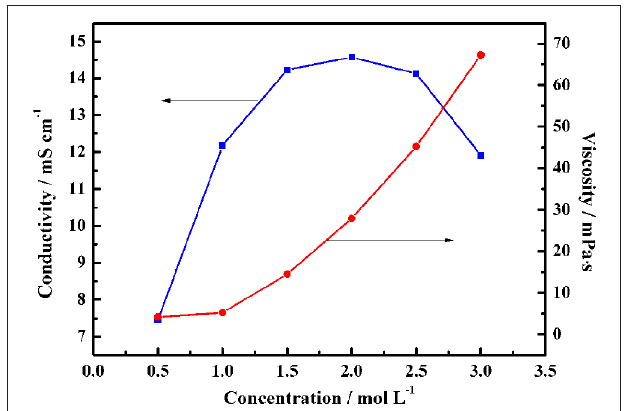
FIGURE 3 | Relationship between conductivity (viscosity) and concentration of Py 13 DFOB/PC at 20 ◦ C.